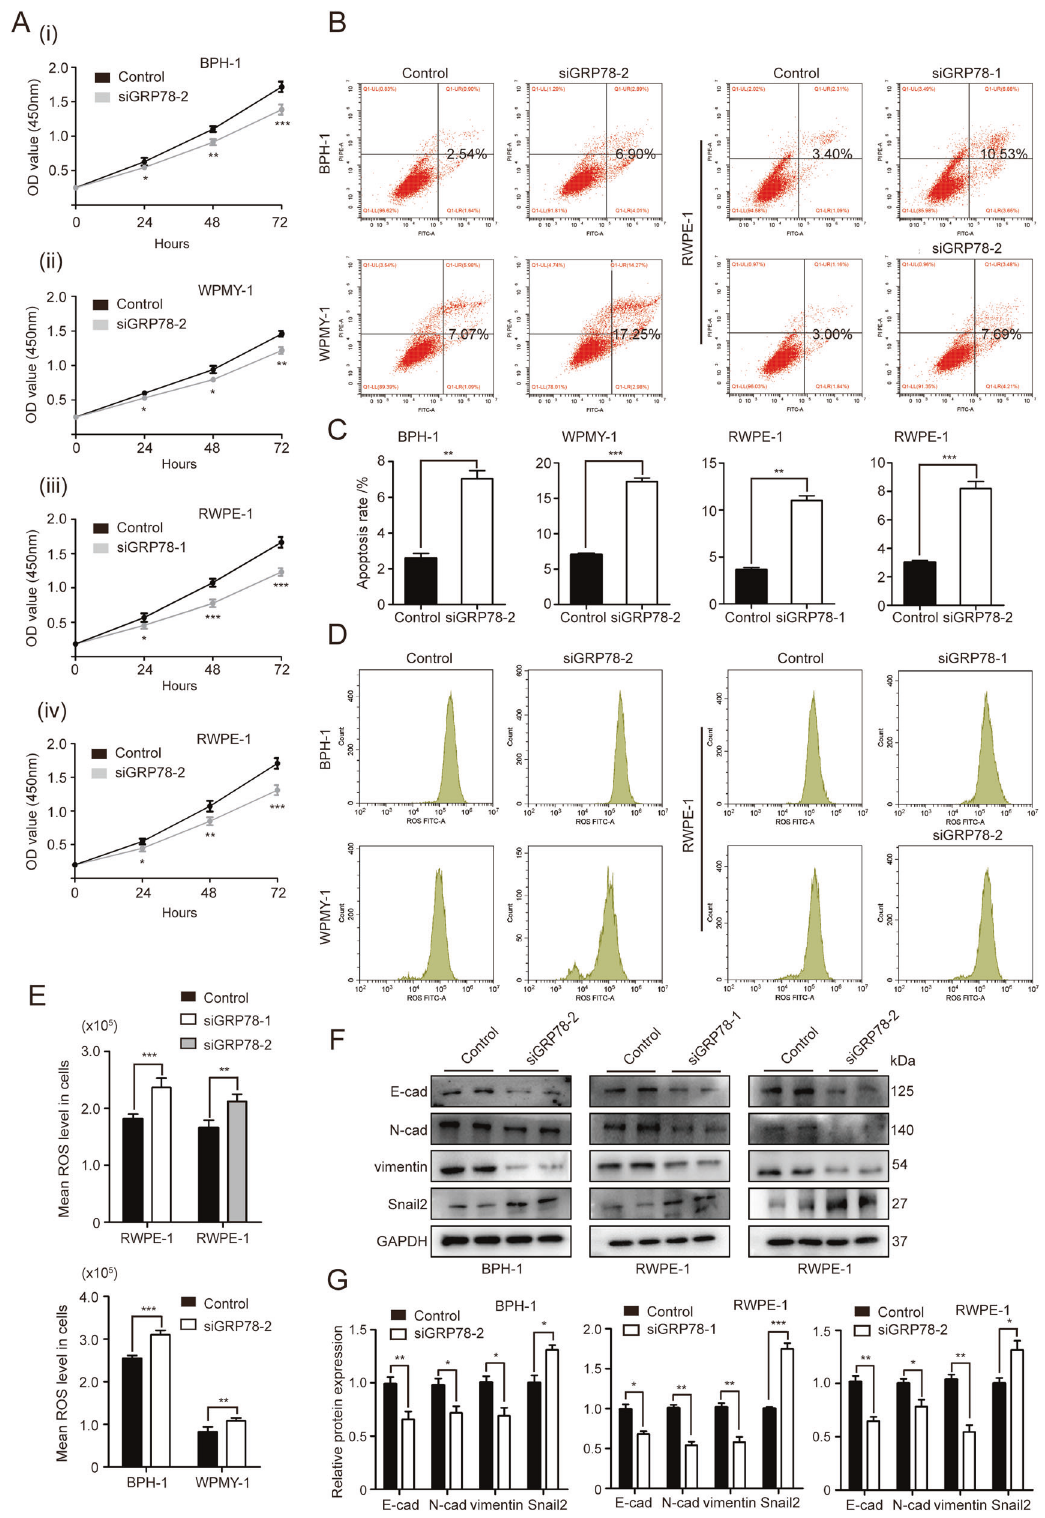
Fig. 8 GRP78 regulates proliferation, apoptosis, as well as EMT and OS status in prostate cells validated by siGRP78 – 2 and another cell line RWPE-1. A Cell viability of BPH-1, WPMY-1 and RWPE-1 cells after GRP78 knockdown with siGRP78 – 1 or siGRP78 – 2 at different time points (0, 24, 48, 72 h) by CCK8 assay. B Flow cytometry analysis of prostate cell apoptosis after transfection with siGRP78. C Statistical analysis for apoptotic rate (%) of three prostate cell lines. D Flow cytometry analysis for ROS generation in three cell lines transfected with either siGRP78 – 1 or siGRP78 – 2. E The statistical analysis for mean ROS level. F , G Immunoblot assay and relative densitometric quanti fi cation of EMT markers (E-cad, N-cad, vimentin and Snail2) in GRP78-silenced BPH-1 cells. GAPDH is used as loading control. * p < 0.05; ** p < 0.01; *** p < 0.001.